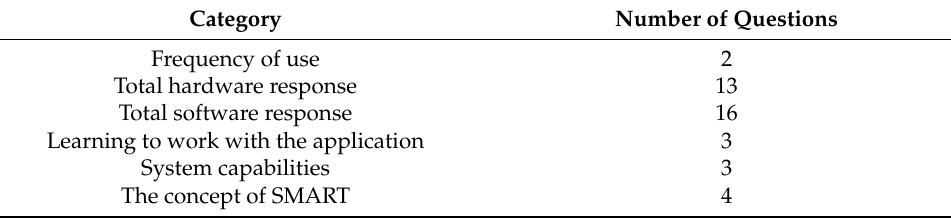
Table 6. Categories and number of questions for questionnaire for